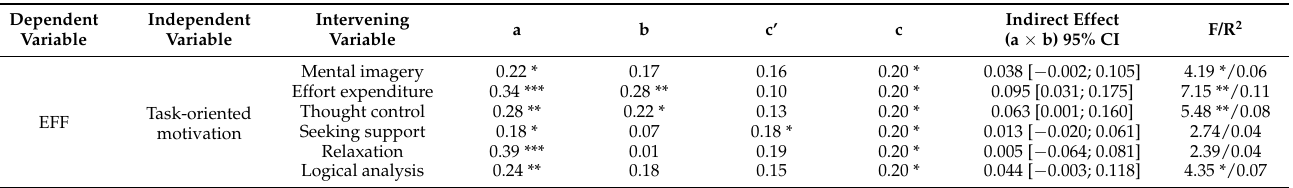
Table 1. Mediational analysis of the relationship between task orientation, styles of coping with stress, and performance